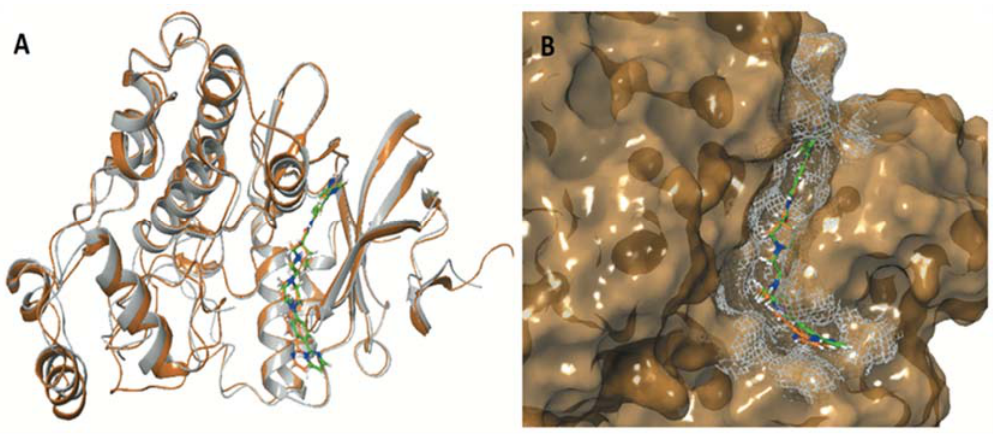
Figure 6. ( A ) Alignment of ERK1 (PDB ID 4QTB) (ribbons with silver) and ERK2 (PDB ID 4QTA) (ribbons with gold) with co-crystallized ligands 38Z0 (green color for ERK1 and orange color for ERK2) and ( B ) Solid surface representation of the crystal structure of ERK1. The crystallographic co-crystallized 38Z0 rendered in green C atoms for ERK1 and the co-crystallized 38Z0 rendered in orange C atoms for ERK2.